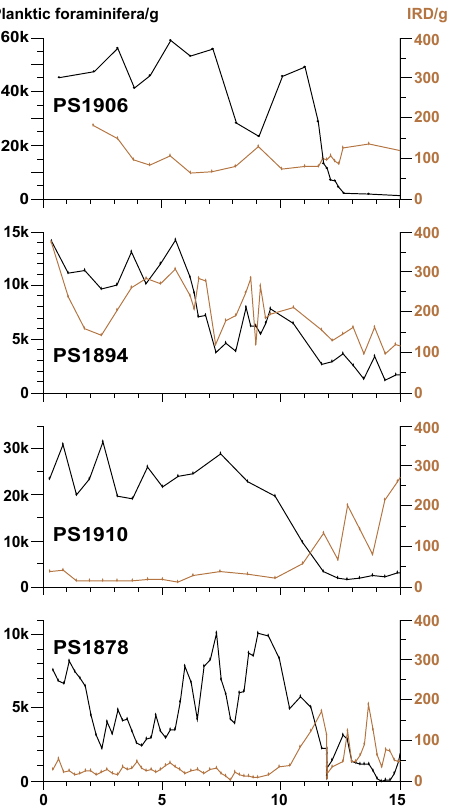
Fig. 8. Planktic foraminifera and IRD abundance (per 1g dry sedi- ment) of cores used in this study, plotted vs. age (since 15ka).